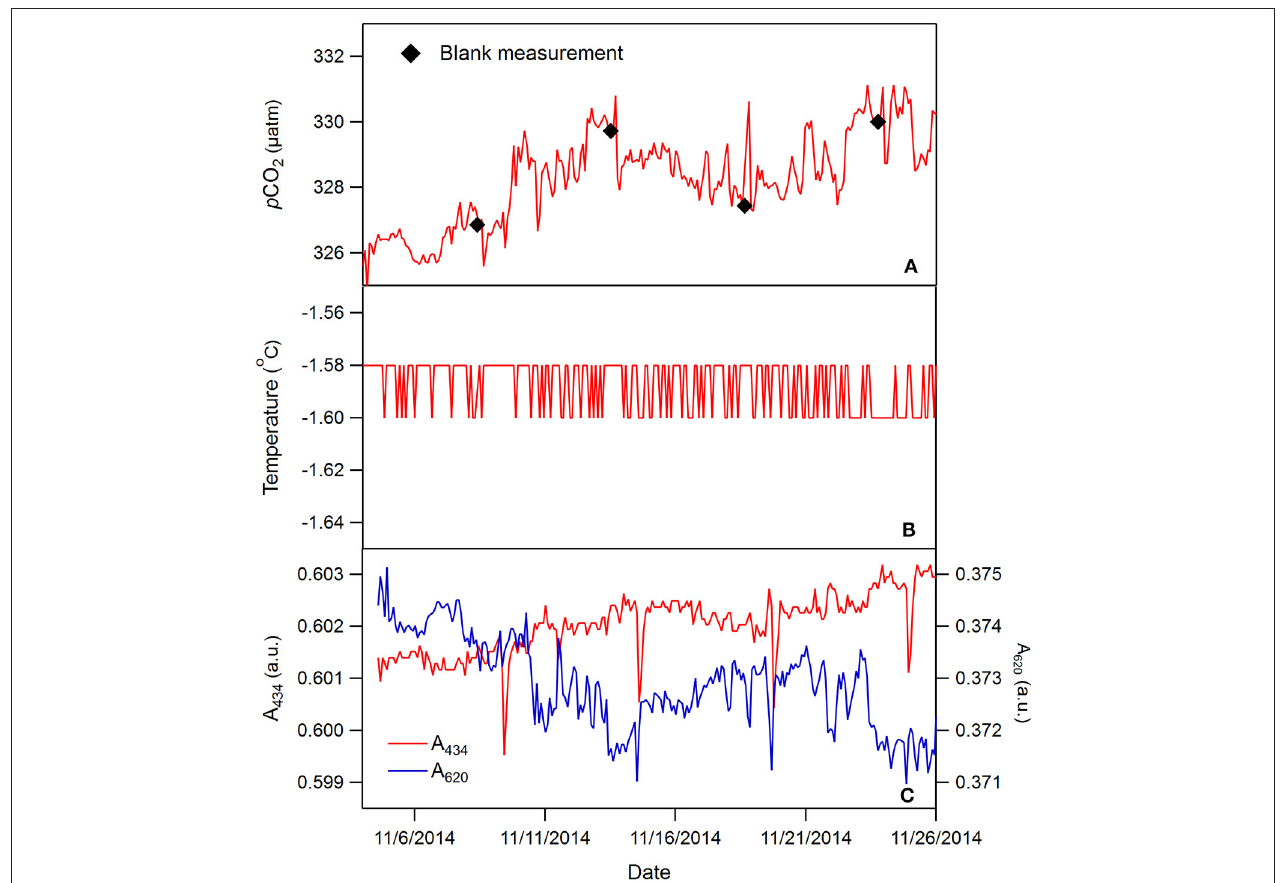
FIGURE 5 | An expanded ∼ 22-day period from Figure 4 showing blank flushing effects. The temperature was essentially constant and below the resolution of the thermistor probe (B) . The absorbances at 434 and 620nm are shown (C) . See text for more discussion.